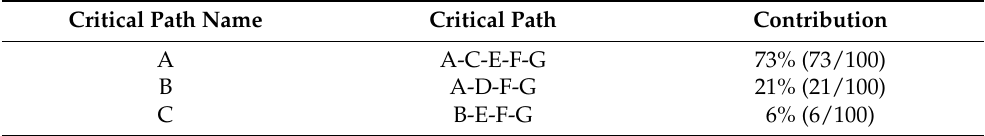
Table 6. Critical path distribution during the simulation run.